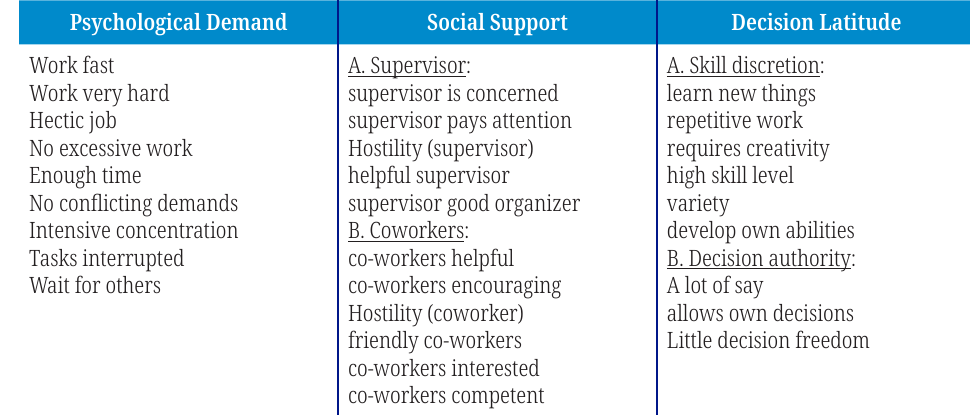
Table 1. The three dimensions of the Karasek